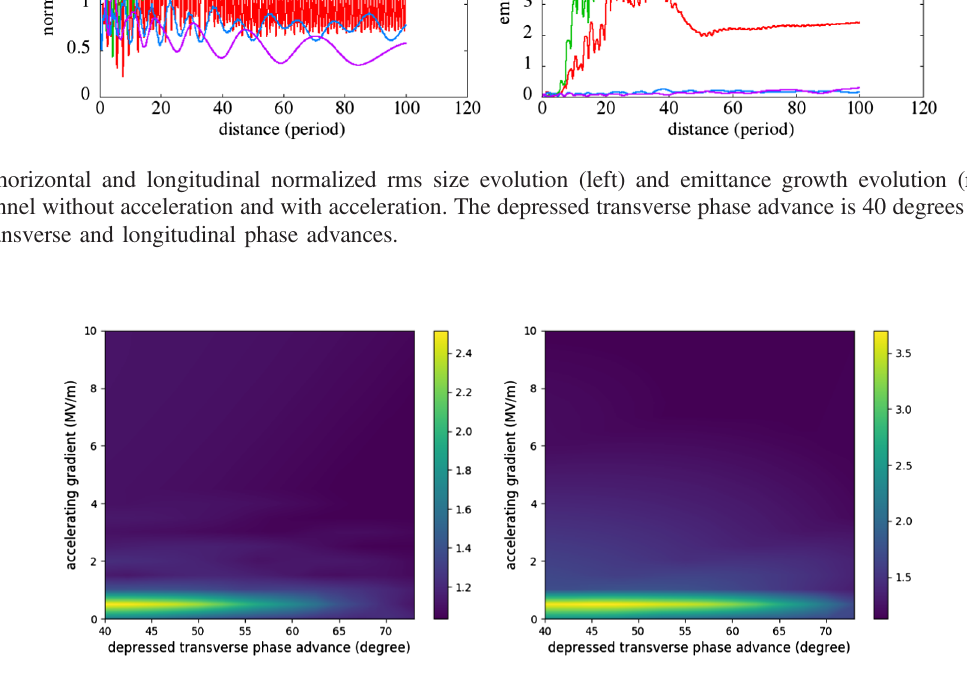
FIG. 4. The maximum normalized horizontal rms amplitude (left) and longitudinal rms amplitude (right) within 100 lattice periods as a function of accelerating gradient and depressed transverse phase advance in the solenoid-rf